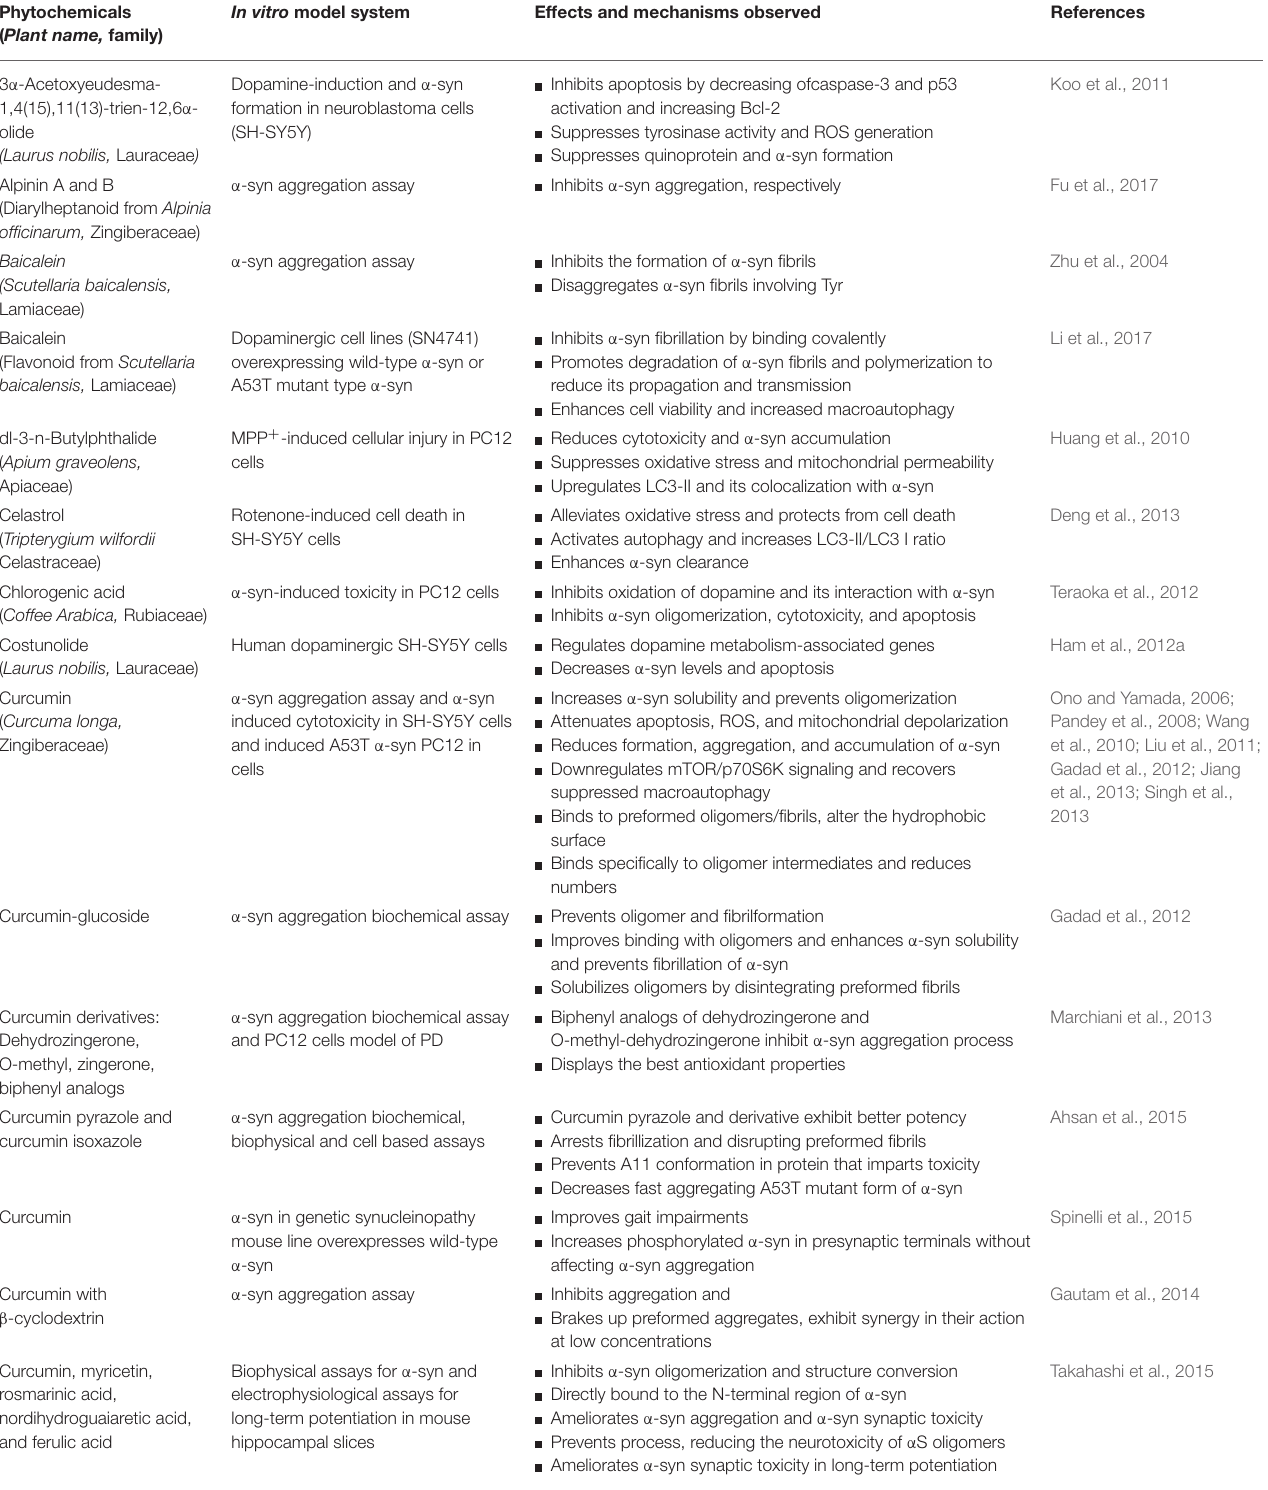
TABLE 2 | The phytochemicals targeting α -synuclein in the in vitro models of Parkinson’s